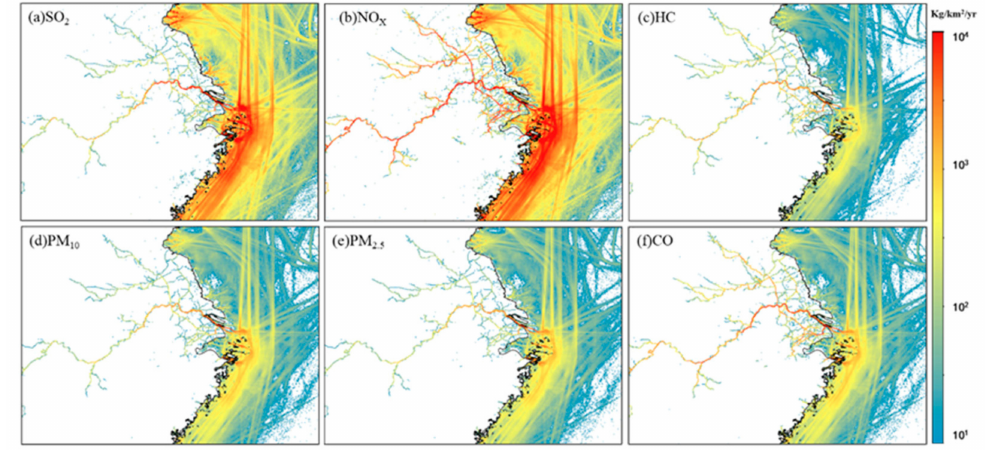
Figure 2. Spatial distribution of annual ship emissions for different pollutions (kg/km 2 /yr) in 2014 over the YRD